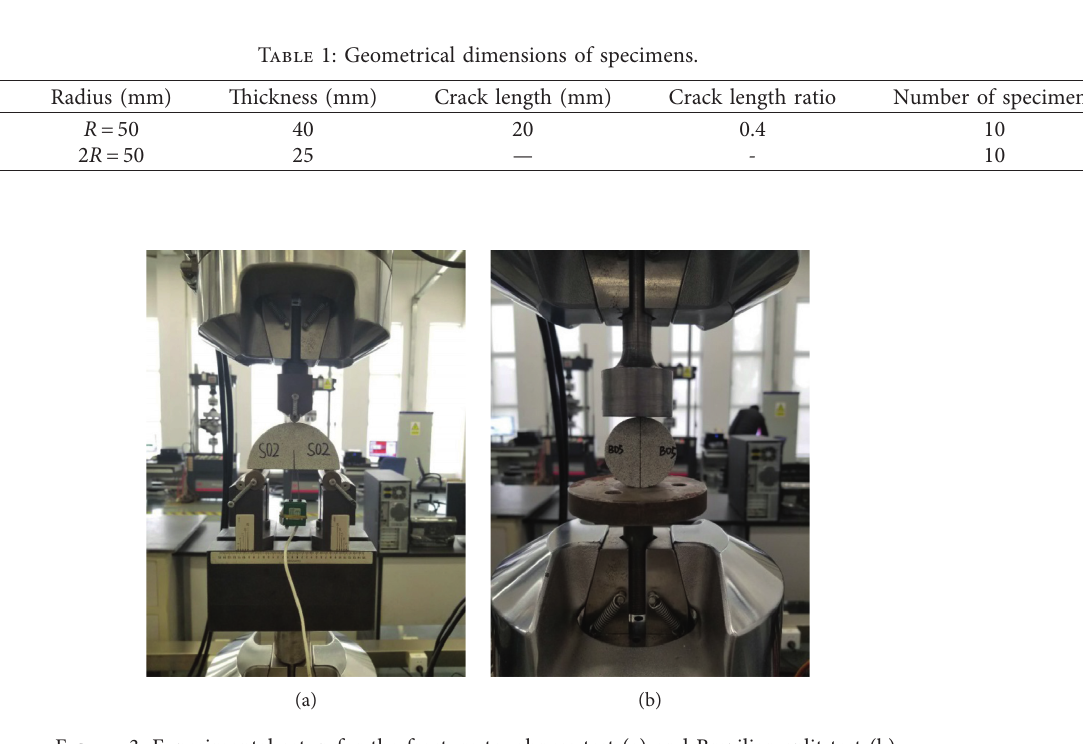
Figure 3: Experimental setup for the fracture toughness test (a) and Brazilian split test